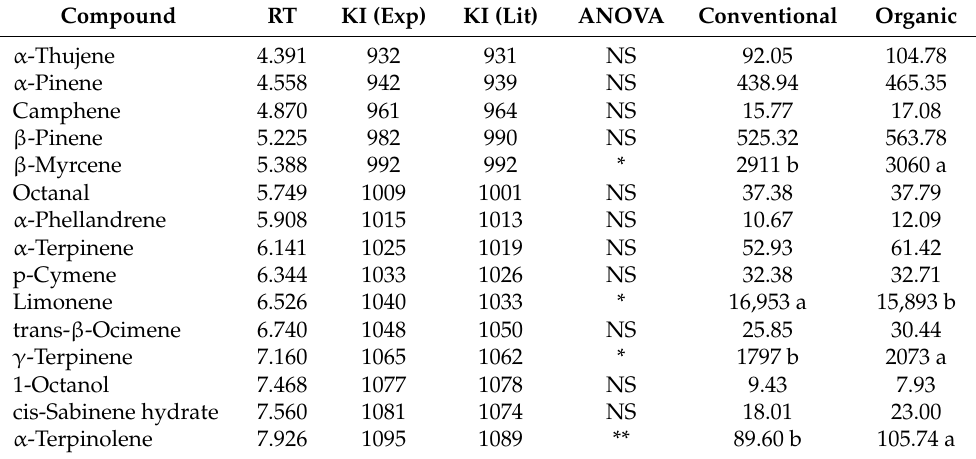
Table 6. Concentrations (mg L − 1 ) of volatile compounds in lemon peel’s oils “Fino 49” cultivated under organic and conventional